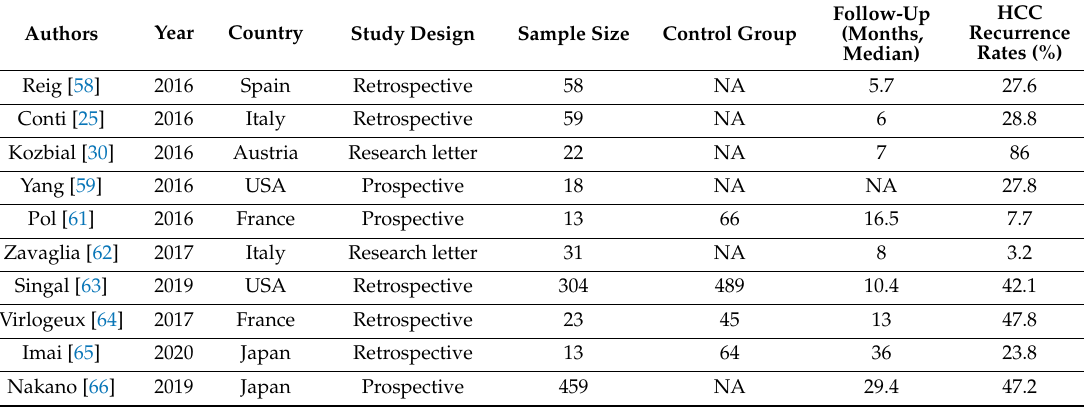
Table 4. Prospective and retrospective study of HCC recurrence after SVR by